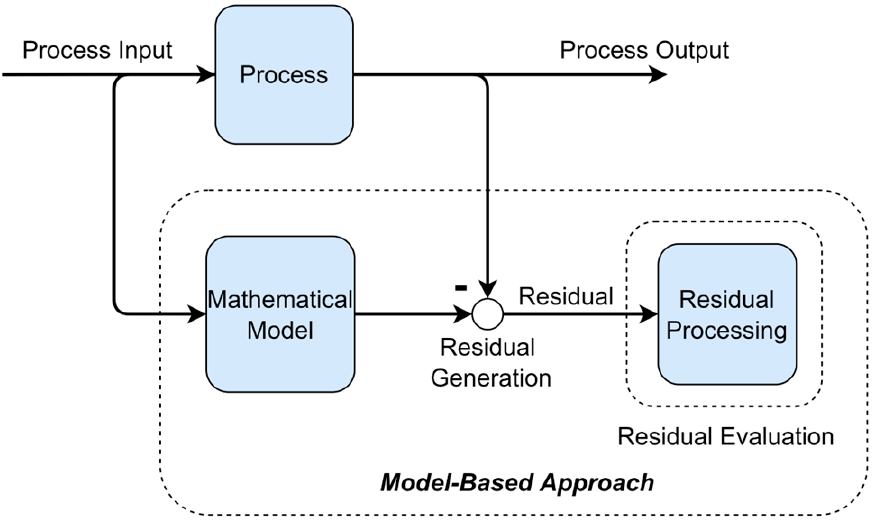
Figure 8. A summary of the model-based approach used for fault detection. Adapted from [85].